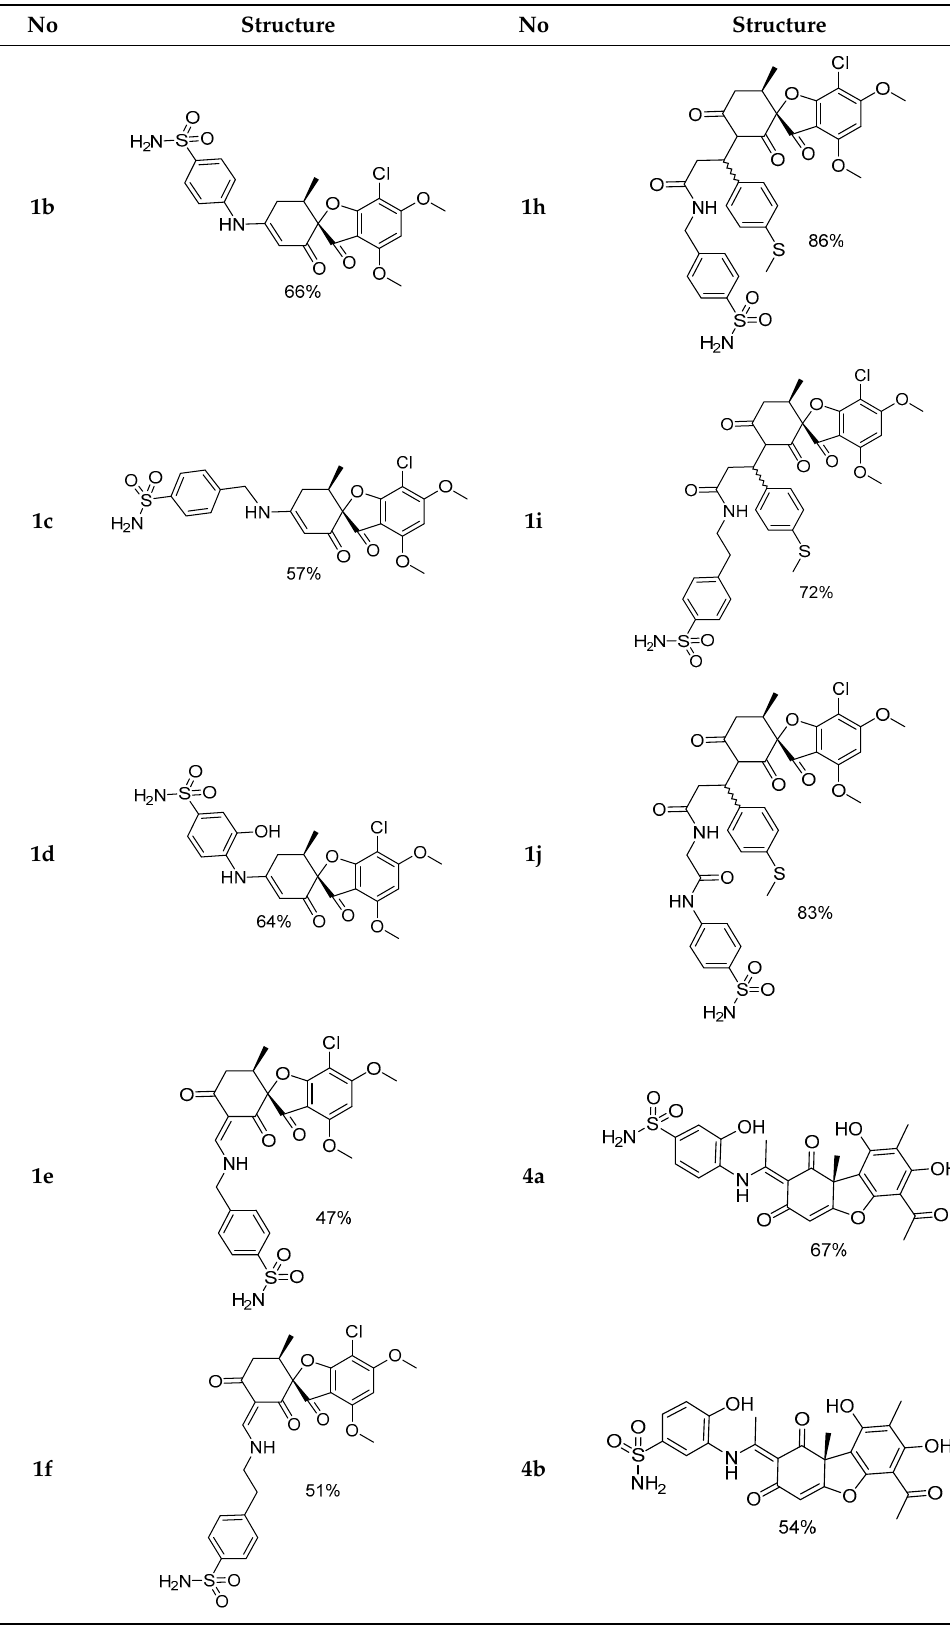
Table 1. Cont . No Structure